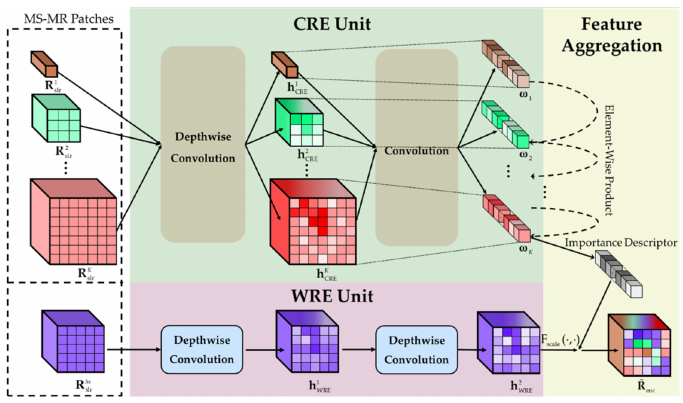
Figure 5. Illustration of the proposed SRE